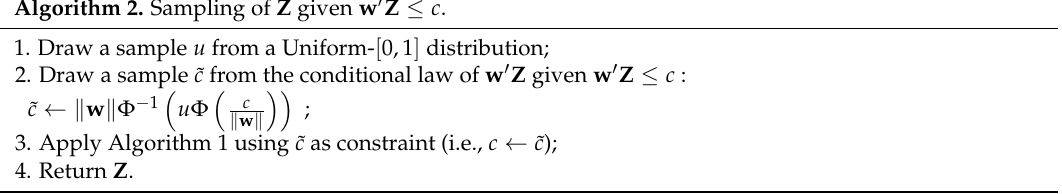
Algorithm 2. Sampling of Z given w (cid:48) Z ≤ c